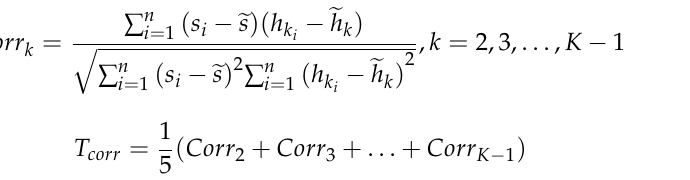
Figure 5. Signal decomposition using the optimal VMD.